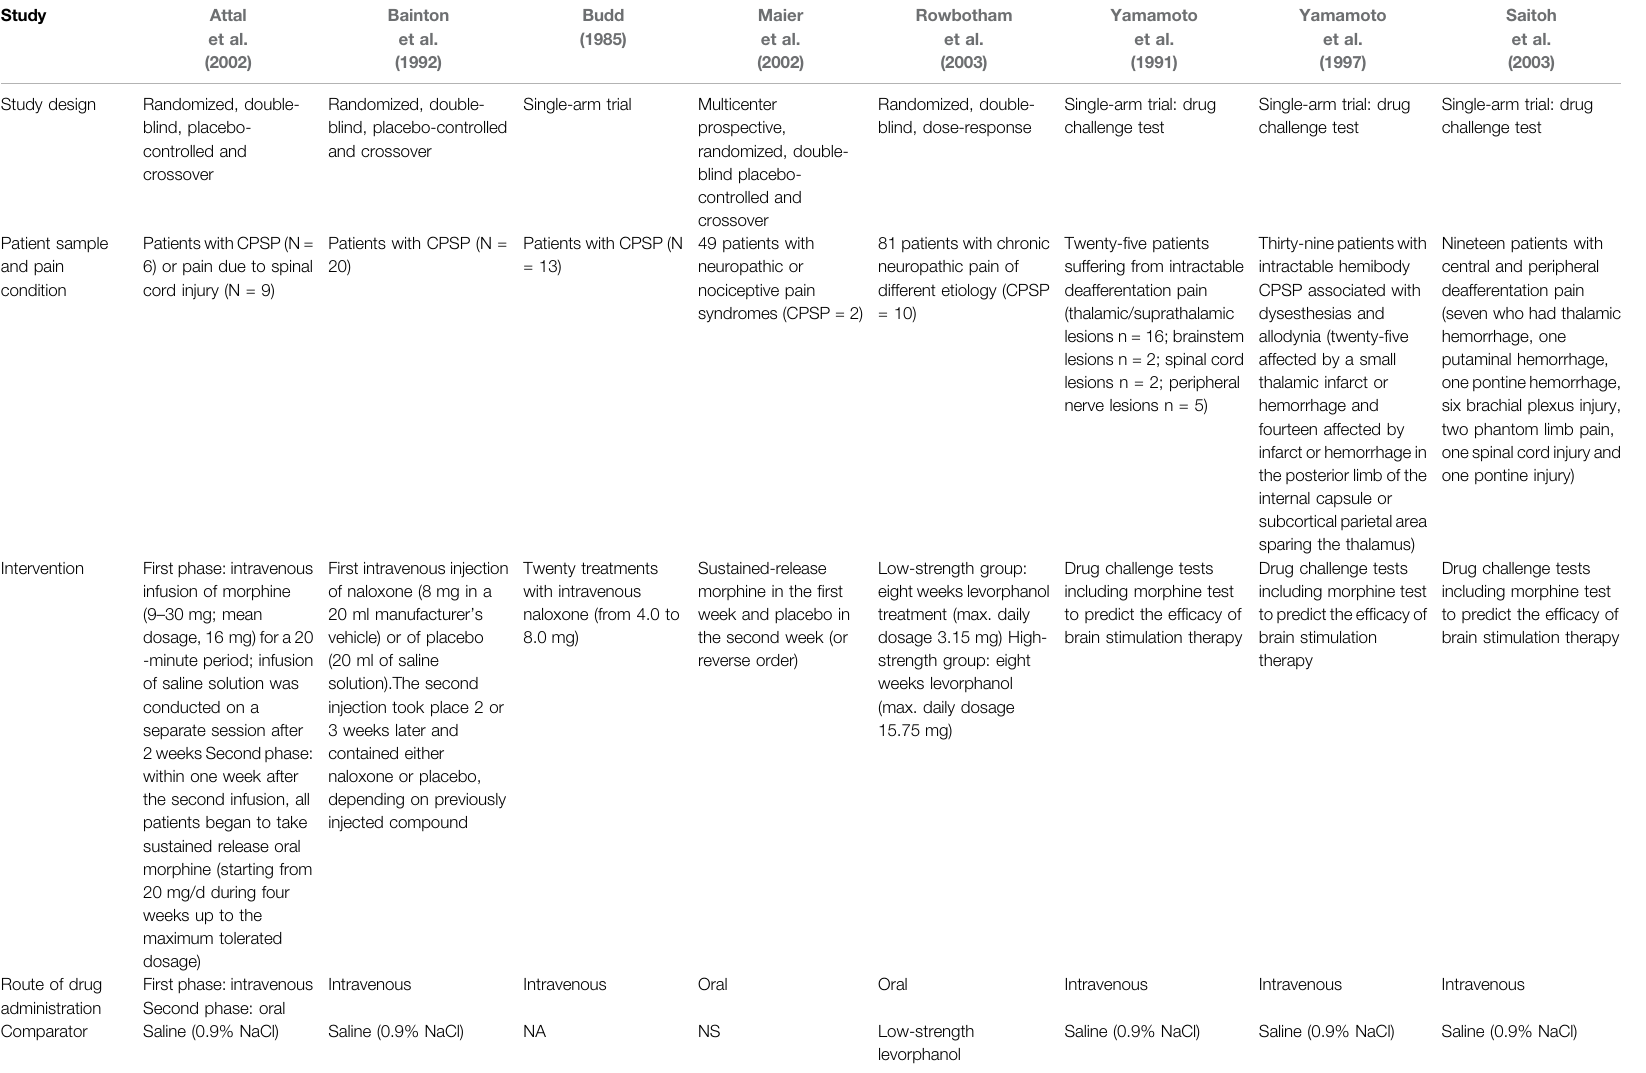
Single-arm trial: drug challenge test